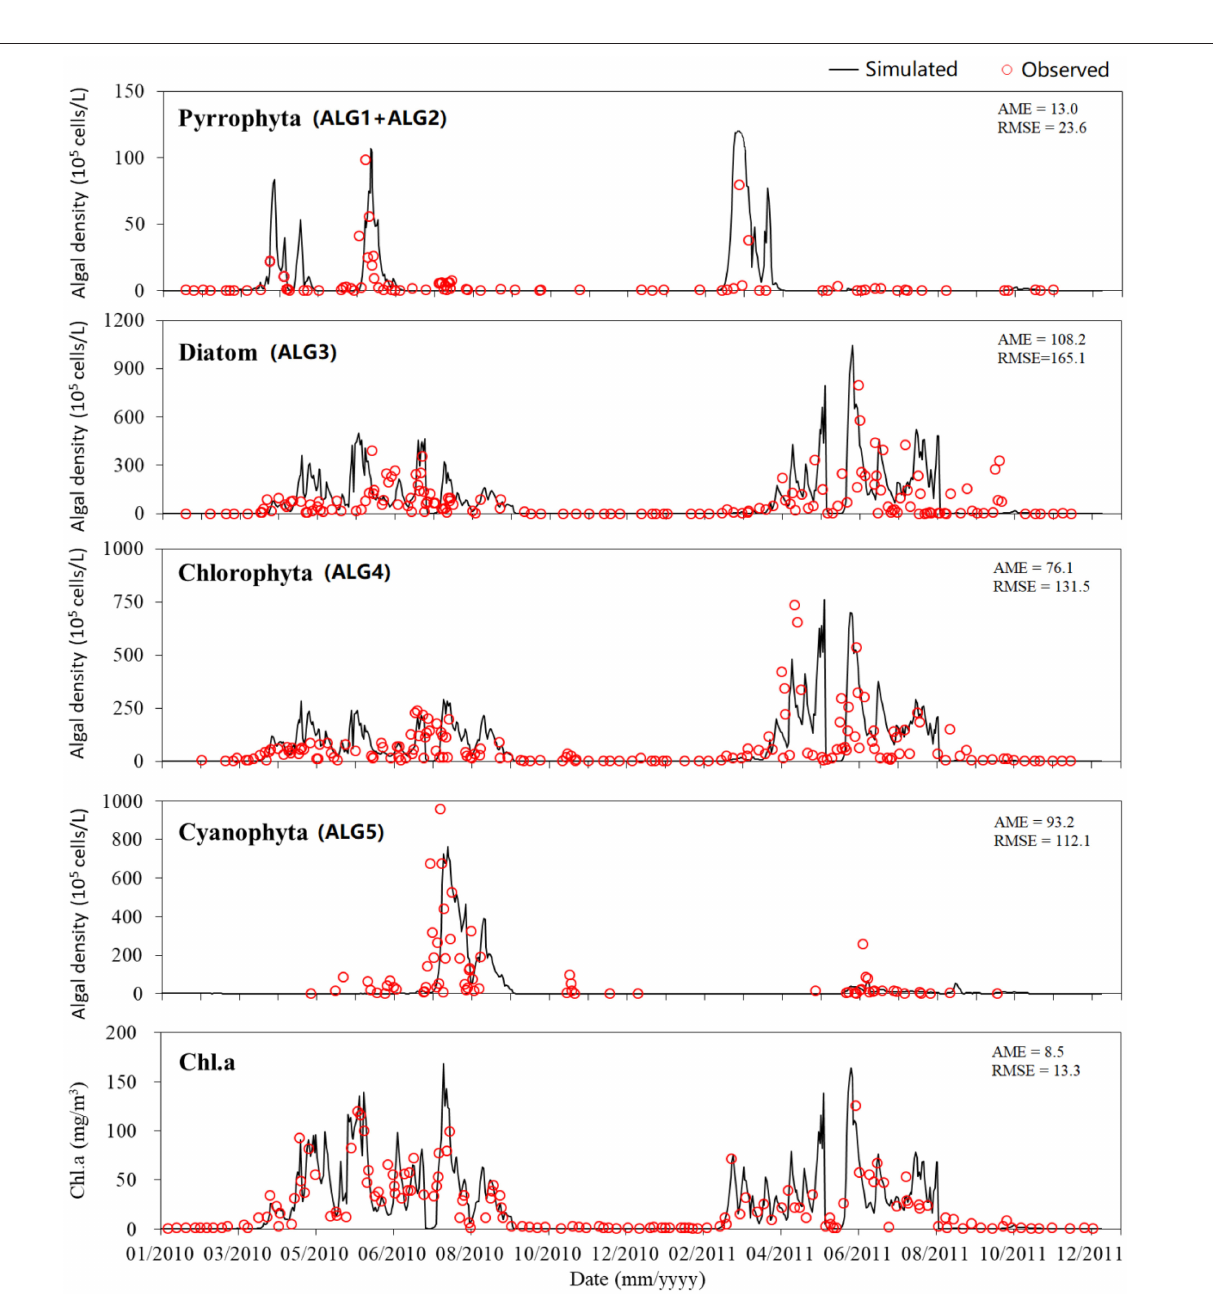
FIGURE 4 | Observed and simulated surface four algal density (Pyrroptata, diatom and cyanophyta, chlorophyta) and Chl.a at S3 in the Xiangxi